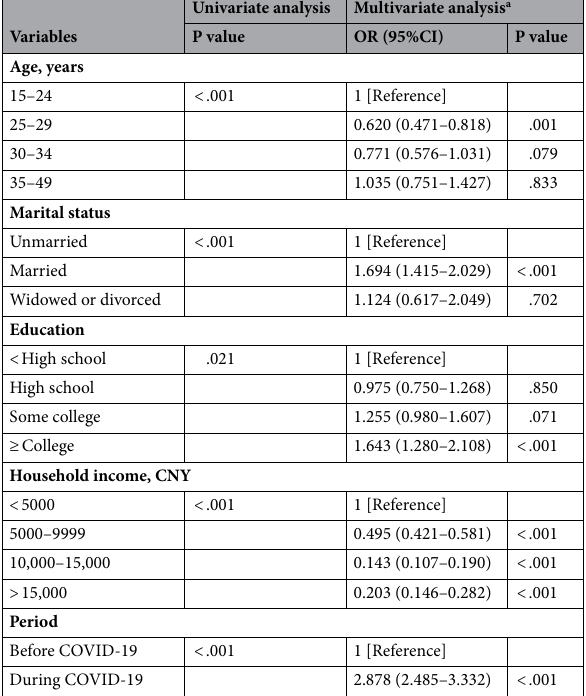
Table 3. Correlates of sexual frequency among subjects as determined logistic regression analysis. a Complete case analysis used for multiple logistic regression resulting included 3624 participants for this model.